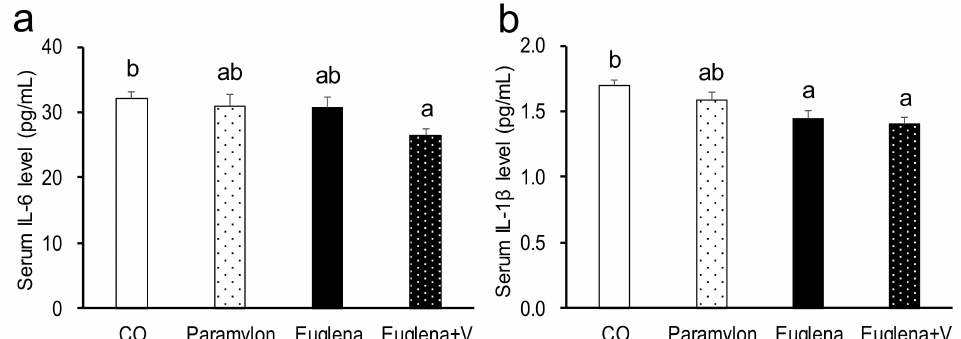
Figure 1. Effects of intake of Euglena and vegetables on inflammation parameters in mice. ( a ) Serum IL-6 level and ( b ) Serum IL-1 β level are presented as the mean ± standard error of the mean, n = 10. Different superscript letters indicate significantly different means at p < 0.05 (refer to “Result” in detail). CO, control diet group; Paramylon, the group that received the normal diet containing 0.3% paramylon; Euglena, the group that received the normal diet containing 1.0% Euglena; Euglena + V, the group that received the normal diet containing 1.0% Euglena and 0.3%